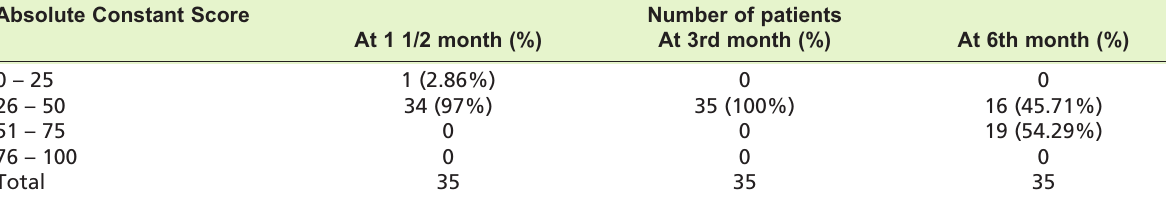
Distribution of absolute constant score post-operatively at each follow-up visit Table V: Absolute Constant Score